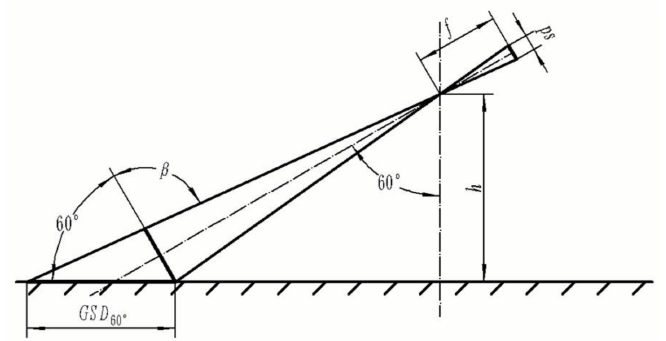
Figure 2. Schematic of the focal length